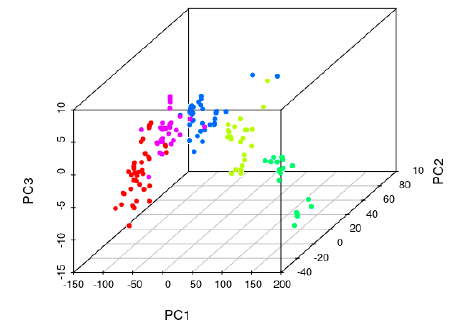
ff erent levels of N are color